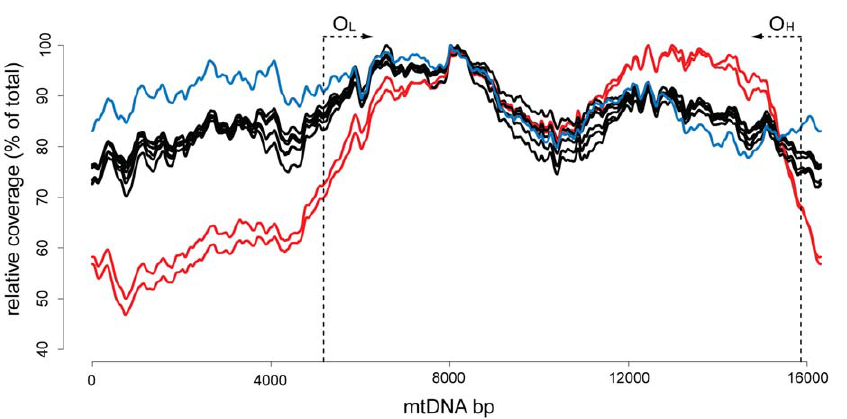
Figure 1. Sequence coverage for the mouse mtDNA samples. Mitochondrial genome position (x-axis) versus sequence coverage divided by maximum coverage for each sample. The coverage was calculated using a 2 kb sliding window average. The red lines correspond to mtDNA mutator samples. All other mouse samples are in black. The blue line represents the sequence coverage of the l mtDNA control. The approximate locations of the origins of light-strand (O L ) and heavy-strand (O H ) replication are indicated by dotted lines with arrows.